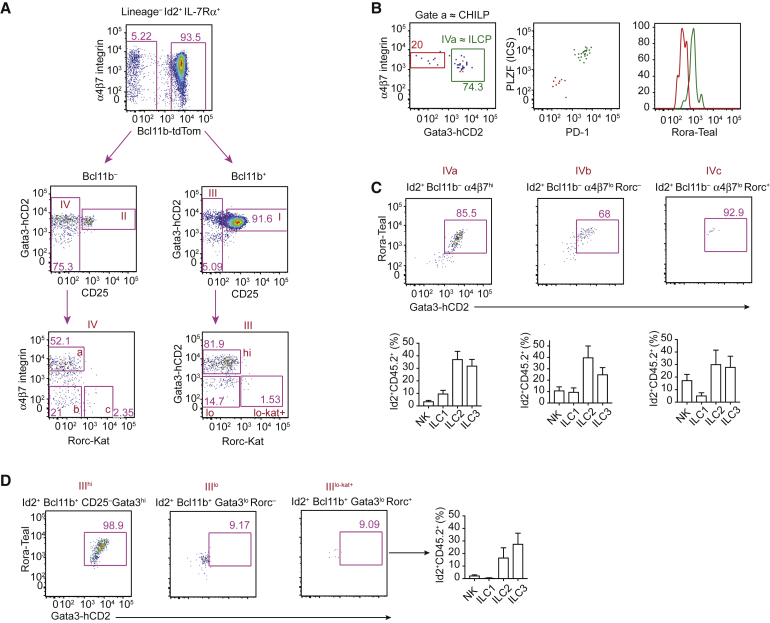
ILCP-Related Cells Indicate Additional ILC Progenitor Heterogeneity(A) Alternative gating strategy for the characterization and purification of populations I, III, and IV from 5x polychromILC bone marrow, to identify Rorc-Kat-positive and -negative progenitors (populations IVa, IVb, IVc, and IIIlo-kat+) (see Table S1).(B) Flow-cytometry analysis of Gata3-hCD2, α4β7, PD-1, PLZF (intracellular stain [ICS]), and Rora-Teal expression within gate IVa (Lin−IL-7Rα+Id2+CD25−α4β7hi), which corresponds with CHILP (Lin−IL-7Rα+Id2+Flt3−α4β7hi). The green gate represents Gata3hi subset (Pop IVa); the red gate represents Gata3lo subset.(C) Flow-cytometry analysis of siLP to identify ILC progeny generated in vivo after the individual adoptive transfers of progenitor cell populations IVa, IVb, and IVc, purified from the bone marrow of 5x polychromILC mice, into Rag2−/−Il2rgc−/− recipients.(D) Flow-cytometric characterization of progenitor cell subpopulation IIIlo-kat+ and analysis of the ILC progeny in siLP after the adoptive transfer of IIIlo-kat+ progenitors, purified from the bone marrow of 5x polychromILC mice, into Rag2−/−Il2rgc−/− recipients.Data are pooled from 2–4 independent experiments and represent mean ± SEM of 6–14 mice per group.